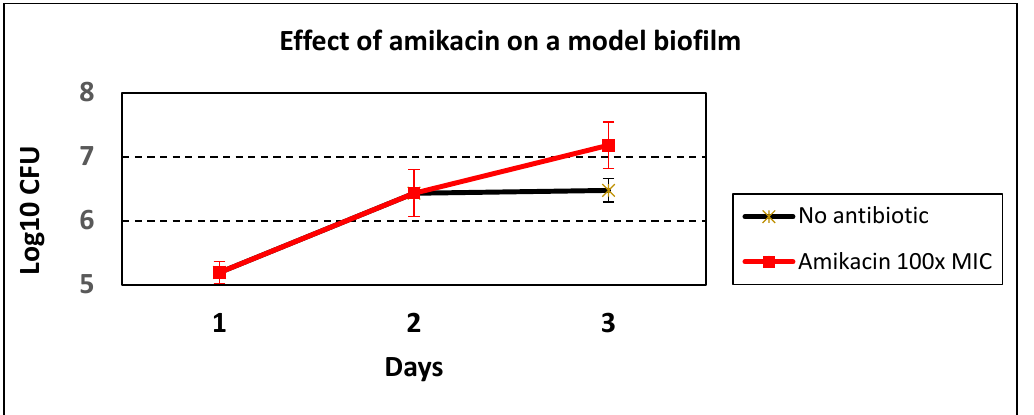
Figure 4. The effect of high dose antibiotic (Amikacin at 100× MIC) on an early-stage biofilm of Pseudomonas aeruginosa